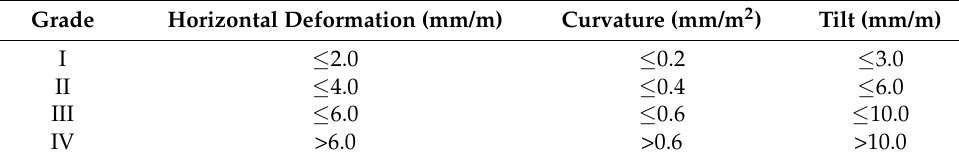
Table 2. State classification criteria of the buildings damage grade